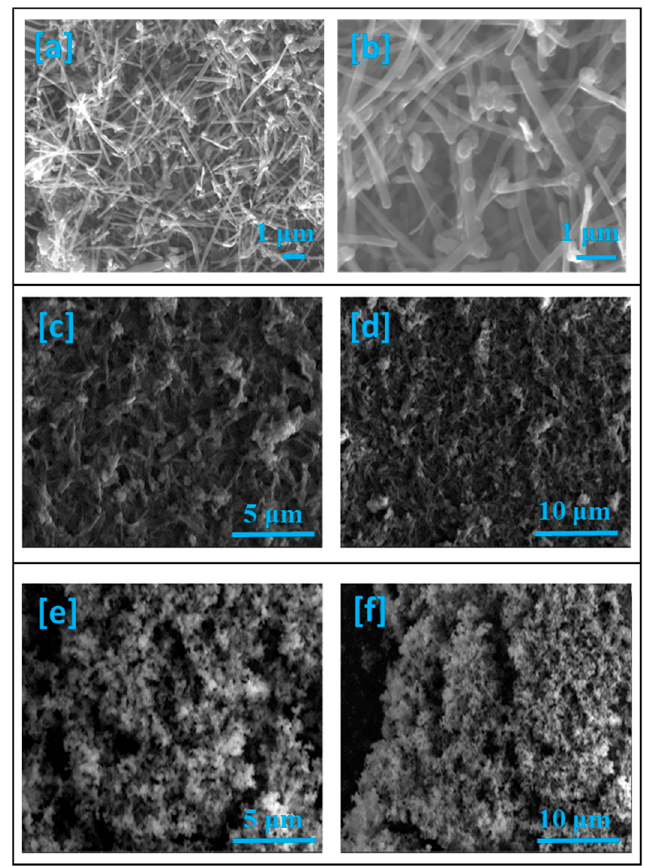
Figure 1. SEM images of ( a , b ) multiwall carbon nanotubes (MWCNTs); ( c , d ) graphene oxide nanoribbons (GONRs) and ( e , f ) polypyrrole (PPy) at various magnifications.